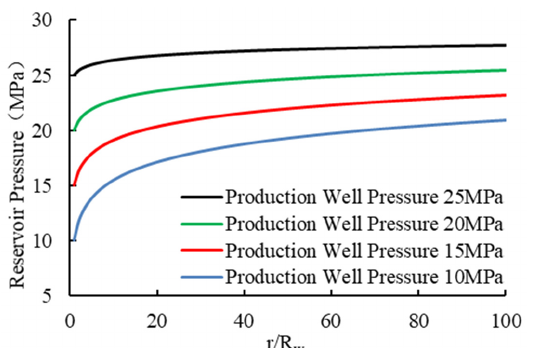
Figure 3. The evolution of reservoir pressure with adjustment wells’ position and production wells’ recovery level.